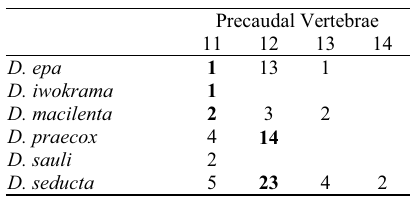
Table 20. Number of specimens of the species of Denticetopsis with cited number of precaudal vertebrae. Bold indicates values for holotype when available. Value for D. royeroi , known only from holotype which could not be radiographed, unavailable.